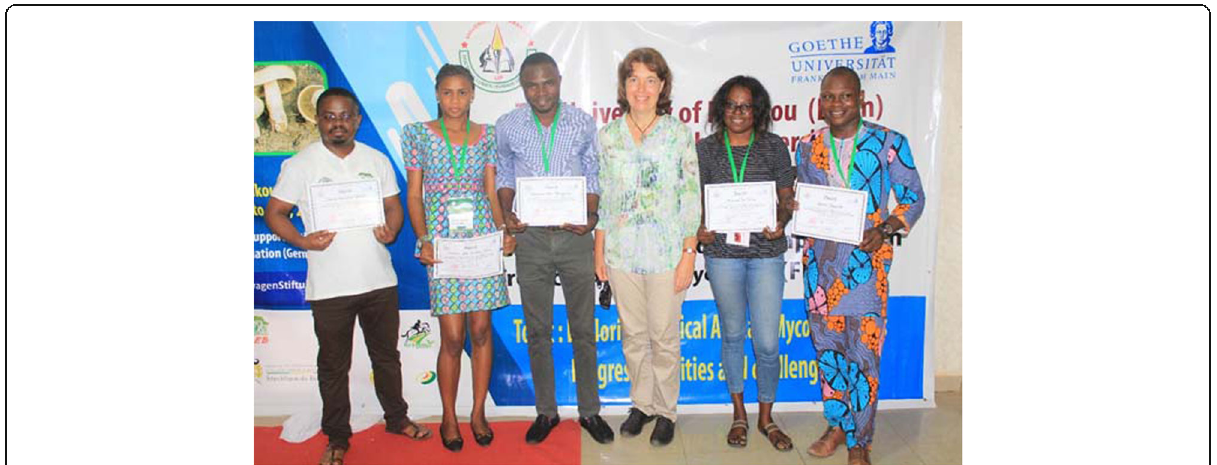
Fig. 15 Young mycologist awardees: Héritier Milenge Kamalebo (DR Congo), Leontine Nicole Ematou Njiki (Cameroon), John Yangyuoru